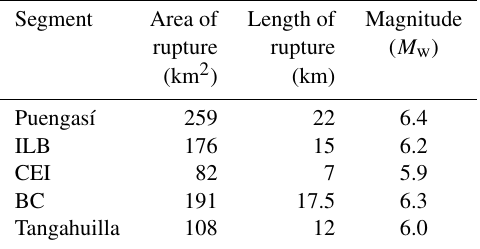
can be observed that in some areas houses have been built on both sides of the hills (Puengasí).